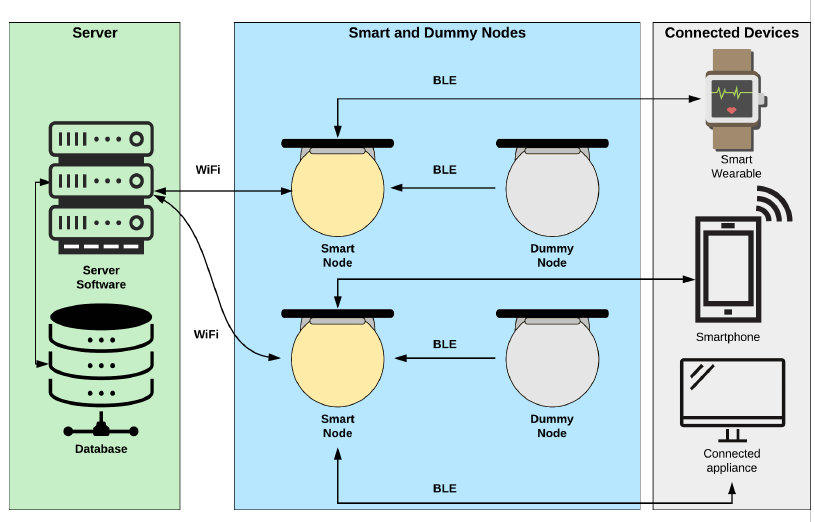
Figure 1. High-level architecture of the